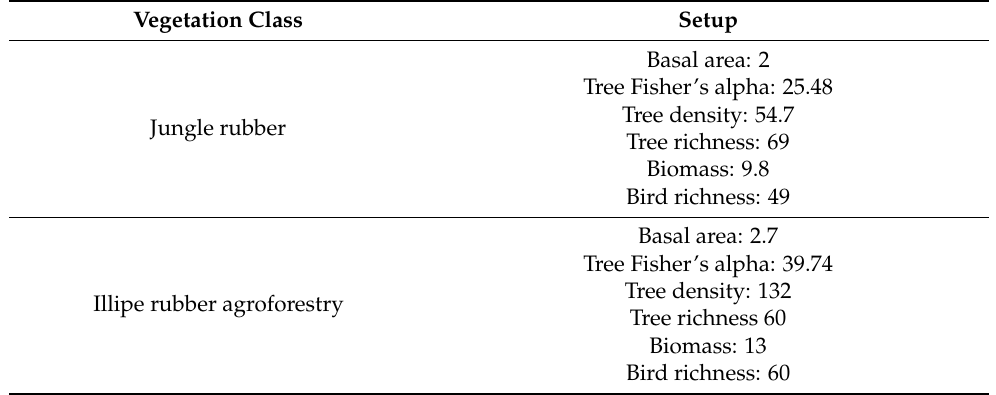
Basal area: 2 Tree Fisher’s alpha: 25.48 Tree density: 54.7 Tree richness: 69 Biomass: 9.8 Bird richness: 49 Basal area: 2.7 Tree Fisher’s alpha: 39.74 Tree density: 132 Tree richness 60 Biomass: 13 Bird richness: